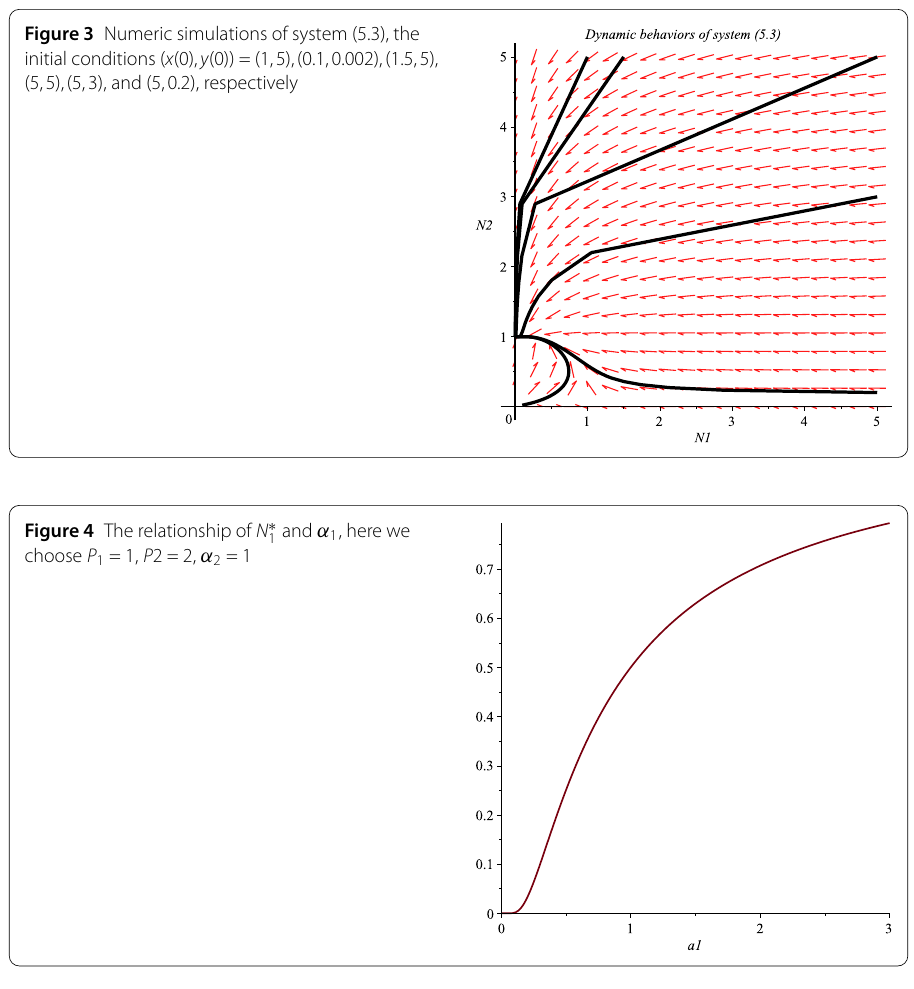
Figure 3 Numeric simulations of system (5.3), the initial conditions ( x (0), y (0)) = (1,5),(0.1,0.002),(1.5,5), (5,5),(5,3), and (5,0.2), respectively